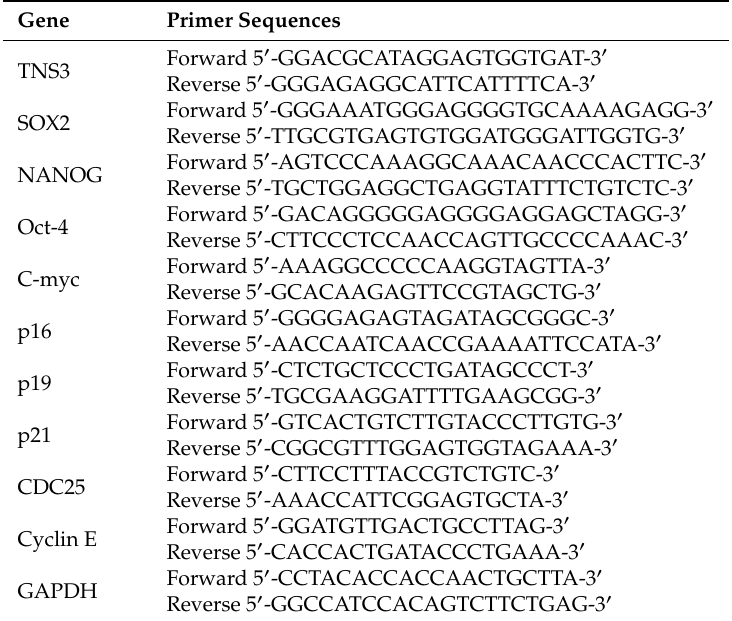
Table 1. Primer sequence used in real-time polymerase chain reaction